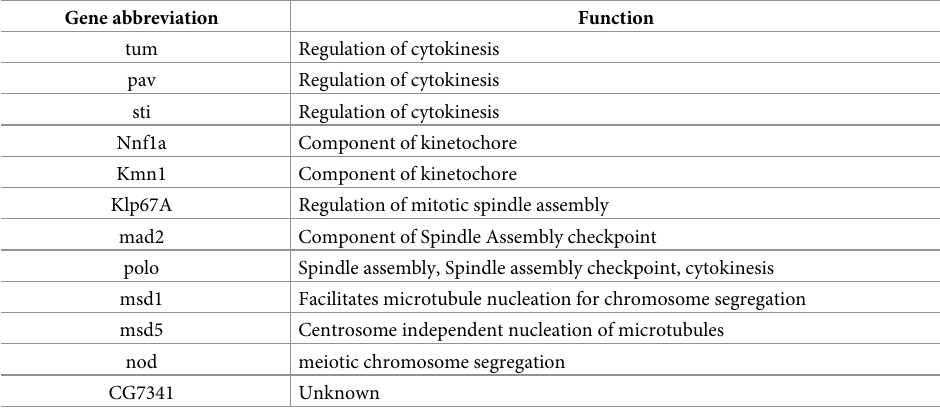
Table 1. Downregulated E2F1 and Myb dependent genes common to iECs and